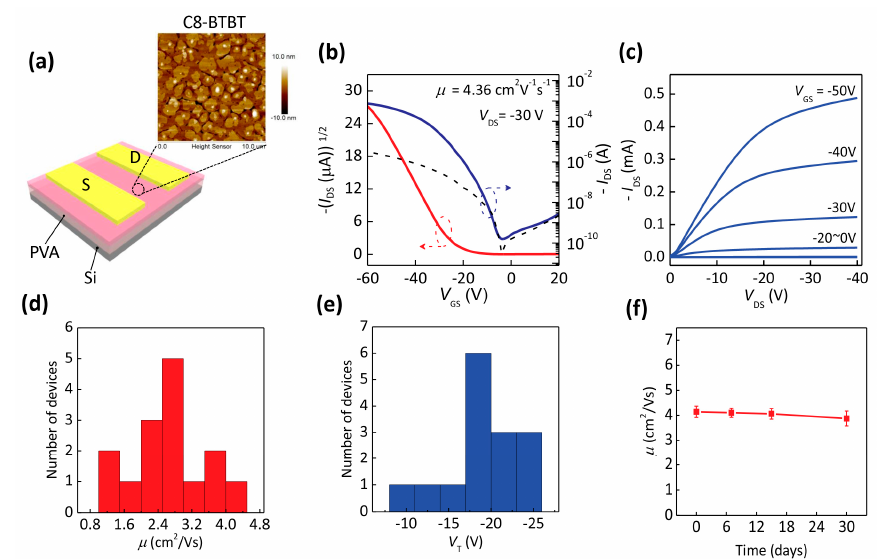
Figure 2. ( a ) Schematic view of the fabricated OTFTs and atomic force microscopy (AFM) image of the C8-BTBT thin film on a PVA dielectric layer. ( b , c ) Typical transfer and output characteristics of the device. The dotted line indicates the gate leakage current. ( d , e ) Histogram distributions of the mobility ( μ ) and threshold voltage ( V T ). ( f ) Dependence relationship of the field-effect mobility on the storage time.